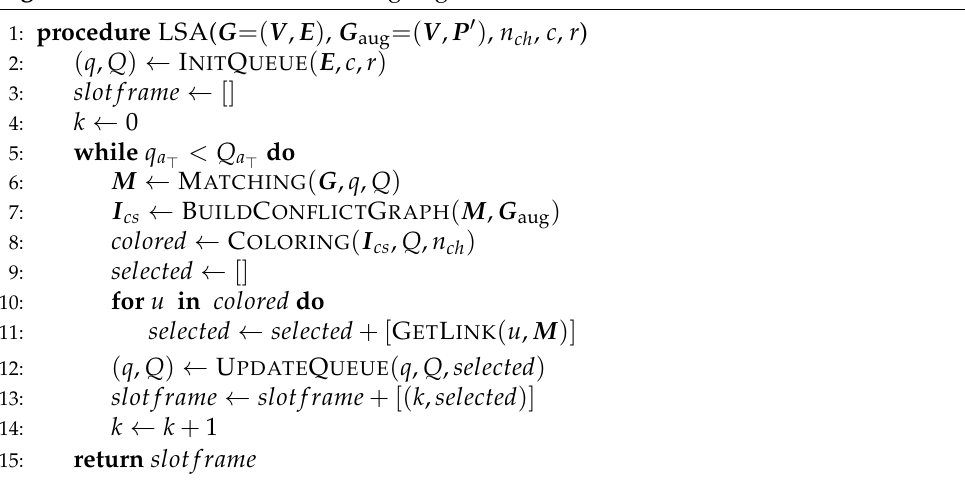
Algorithm 1 Localization Scheduling